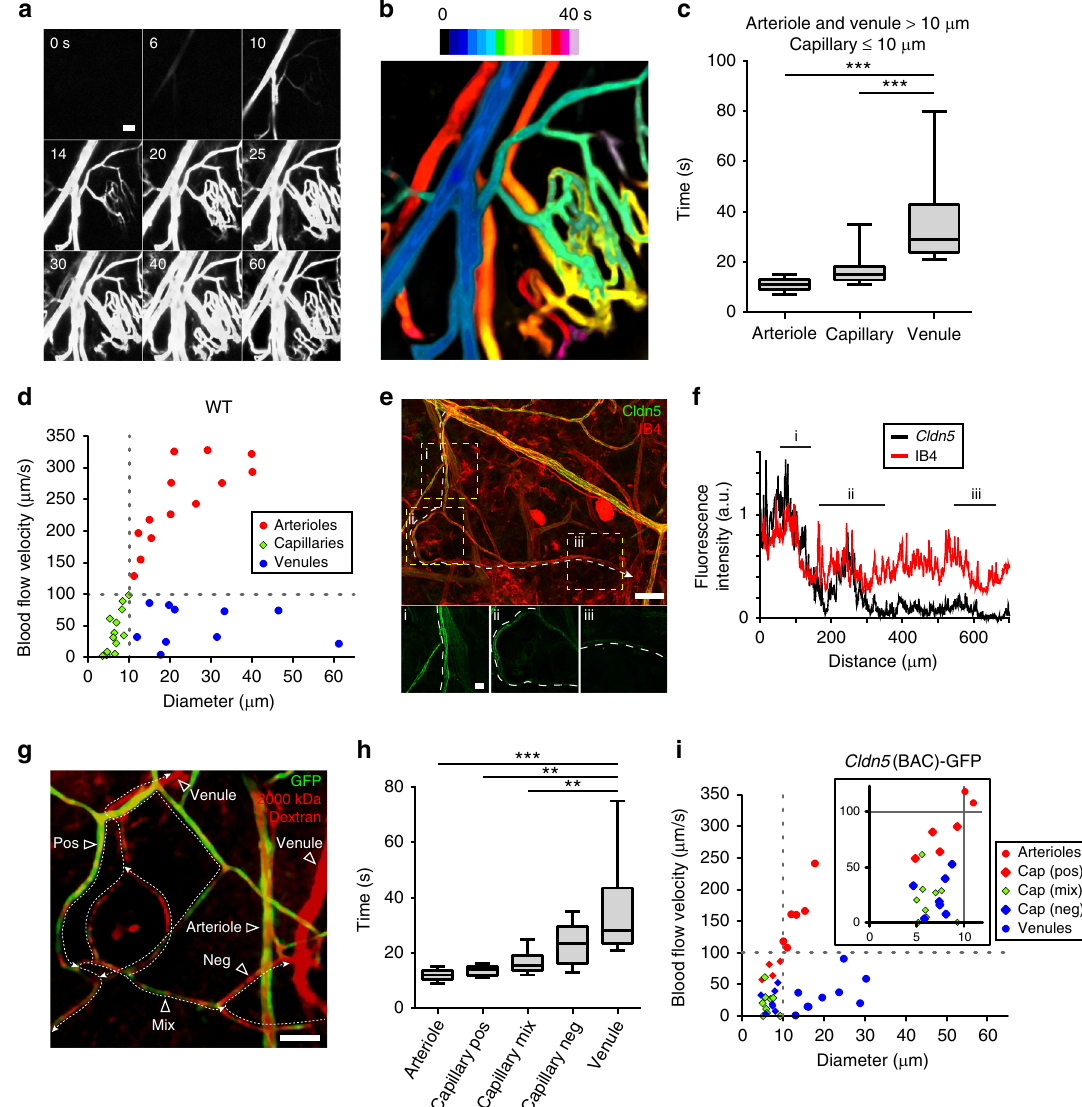
Fig. 2 Identi fi cation of vessel types in the ear dermis. a Distribution kinetics (frames shown at 0 up to 60 s after injection) of 2000 kDa FITC-Dextran injected as a bolus in the tail vein. Single-photon time-lapse imaging (0.5 – 1 s/frame) was performed without pinhole to capture a wide focal depth. Bar, 50 μ m. b Heatmap of the distribution kinetics of 2000 kDa FITC-Dextran, visualizing arterioles (dark blue), capillaries (green to yellow) and venules (yellow to dark red). c Box plot showing distribution kinetics of 2000kDa FITC-Dextran for different vessel types, de fi ned as arterioles and venules (>10 μ m) and capillaries ( ≤ 10 μ m), with median (center line), 25th and 75th percentiles (box bounds), and whiskers (maximum and minimum data point) indicated. n = 7 mice. Tukey – Kramer test; *** p < 0.001. d RBC velocity in arterioles, capillaries, and venules in wild-type C57BL/6 ear dermis. n = 7 mice with >20 RBCs measured/vessel-type (10 – 14 vessels of each type). e Ear dermis vasculature, merged immunostaining for Cldn5 (green), and Isolectin B4 (IB4; red). Boxes labeled i – iii with white dashed vessel outlines are shown as enlarged images below, illustrating consecutive capillary segments that gradually lose Cldn5 expression. Bar, 50 μ m and 10 μ m in lower panels. f Line plot of Cldn5 and IB4 fl uorescence intensities along capillary segments in e . g Cldn5 (BAC)-GFP mouse ear dermis after injection of 2000kDa TRITC-Dextran, with different vessel types indicated. Note that venules and certain capillary segments show circulating TRITC-Dextran (red) but do not express GFP (green). Capillaries with GFP expression (positive; pos), with mixed expression (mix) and no GFP expression (negative; neg) are indicated. Dashed lines with arrowheads show the direction of blood fl ow. Bar, 50 μ m. h Box plot showing distribution kinetics of 2000kDa TRITC-Dextran to different vessel types with median (center line), 25th and 75th percentiles (box bounds) and whiskers (maximum and minimum data points) indicated. Note that dextran reached the GFP-expressing capillaries before non-expressing capillaries. n = 3 mice (independent biological repeats). Tukey – Kramer test; ** p < 0.01, *** p < 0.001. i RBC velocity in arterioles, venules, and different capillaries, positive (pos), mixed (mix), and negative (neg), for GFP expression in Cldn5 (BAC)-GFP ear dermis. n = 3 mice with >20 TRITC-conjugated 400 kDa Ficoll (Fig. 4a). Leakage occurred at magni fi cation to the right). In the Cldn5 (BAC)-GFP mouse the distinct points (denoted leakage points, see Fig. 4a) that were extravascular spread of 400 kDa TRITC-Ficoll also occurred from established at intervals along the vessel length. Leakage points capillaries and veins (Fig. 4b, c). Quanti fi cation of leakage points were detected on capillaries and venules, as distinguished by fl ow in the various vessel types showed no induction of leakage from velocity, quanti fi ed by RVDM, and vessel diameter (Fig. 4a, high GFP-positive, Cldn5-expressing arteries and capillary segments,